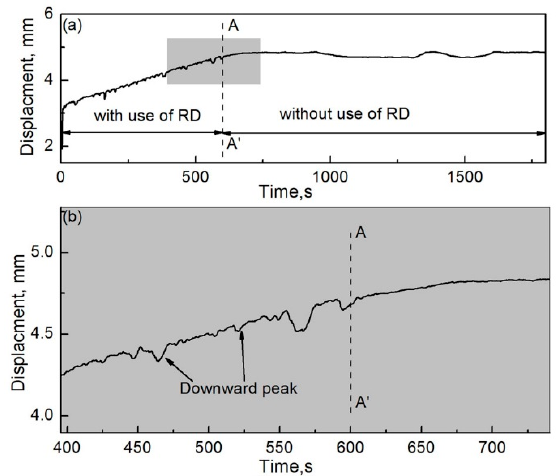
Figure 16 Pin-displacement evolution during segmented friction testing; H = 26.1 × 10 3 A/m. ( a ) Complete drawing and ( b ) local enlarged drawing of the shadowed region in (a).